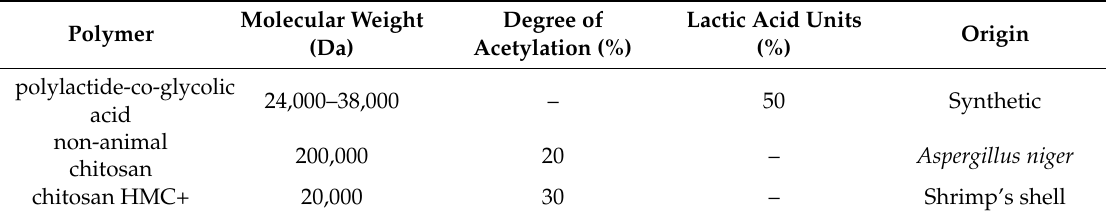
Figure 1. Graphic representation of the different nanoparticles prepared. Table 1. Physicochemical characteristics of the materials used for nanoparticle preparations.